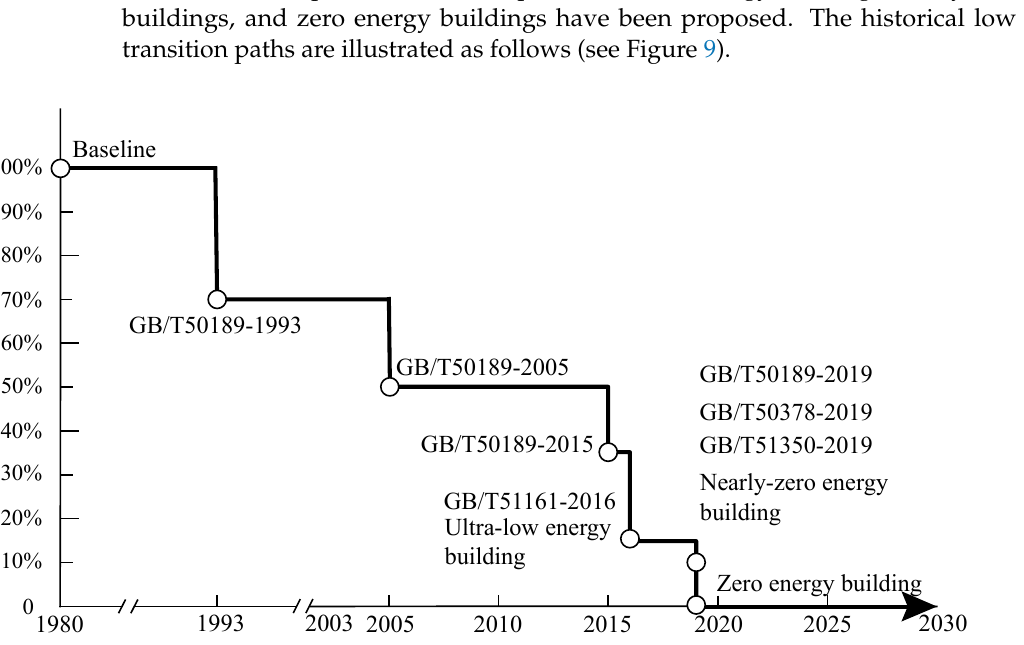
Figure 9. Historical low carbon transition strategies in Chinese commercial building operations from 1980 to 2020.